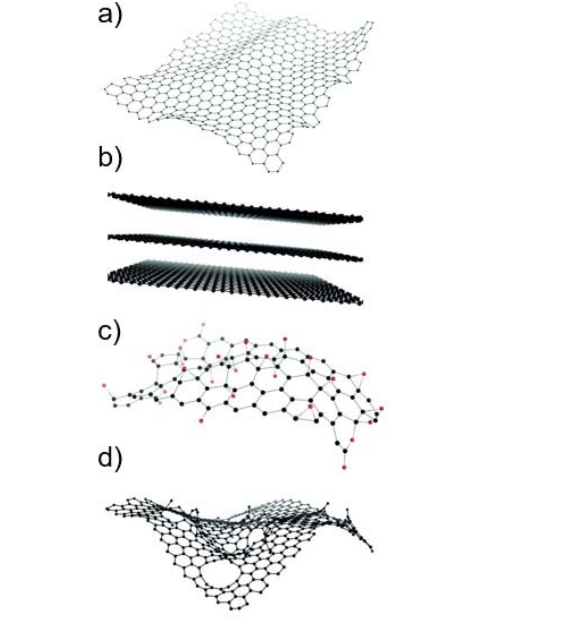
Figure 1. Representative chemical structures of some of the graphene-based materials: ( a ) graphene, ( b ) few-layer graphene, ( c ) graphene oxide (oxygen atoms are in red) and ( d ) reduced graphene oxide. Reprinted with permission from Ref. [1]. Copyright 2013 Wiley Online Library.